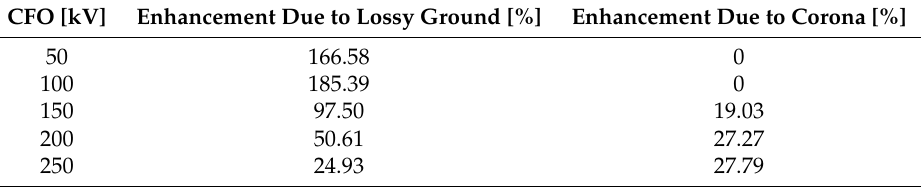
Figure 2. Number of dangerous events on an overhead distribution line. Comparison between perfect ground, lossy ground and lossy ground with corona discharge. Table 2. Percentage enhancement—the second column describes how the lossy ground enhances the number of flashovers with respect to the PEC ground, while the third column describes how the corona effect enhances the number of flashovers with respect to the lossy ground